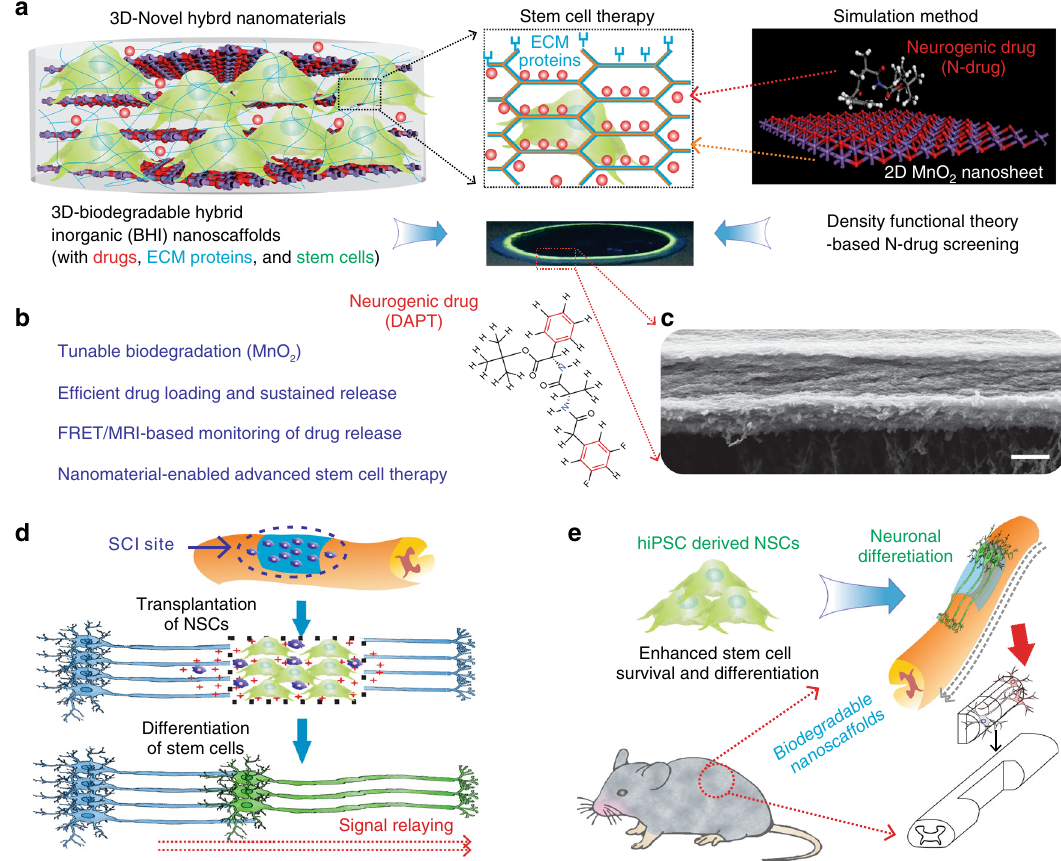
Fig. 1 BHI nanoscaffolds for advanced stem cell therapy. a To develop an effective method for stem cell transplantation, we synthesized a BHI nanoscaffolds that simultaneously integrate advancements in 3D-hybrid nanomaterials and DFT calculations-based precision drug screening. Cells are labeled with green due to their green fl uorescence protein labeling. Laminin proteins are colored in blue. Drugs are represented by red-colored dots. In the simulation scheme, blue colored atoms represent manganese and red colored atoms represent oxygen. b Compared to conventional inorganic scaffolds for stem cell transplantation, our BHI nanoscaffold self-assembled from atomic-thin MnO 2 nanosheets, ECM proteins, and therapeutic drugs has unique advantages including: (i) Redox mediated tunable biodegradation; (ii) Ef fi cient drug loading and sustainable release; (iii) FRET/MRI monitorable drug release;